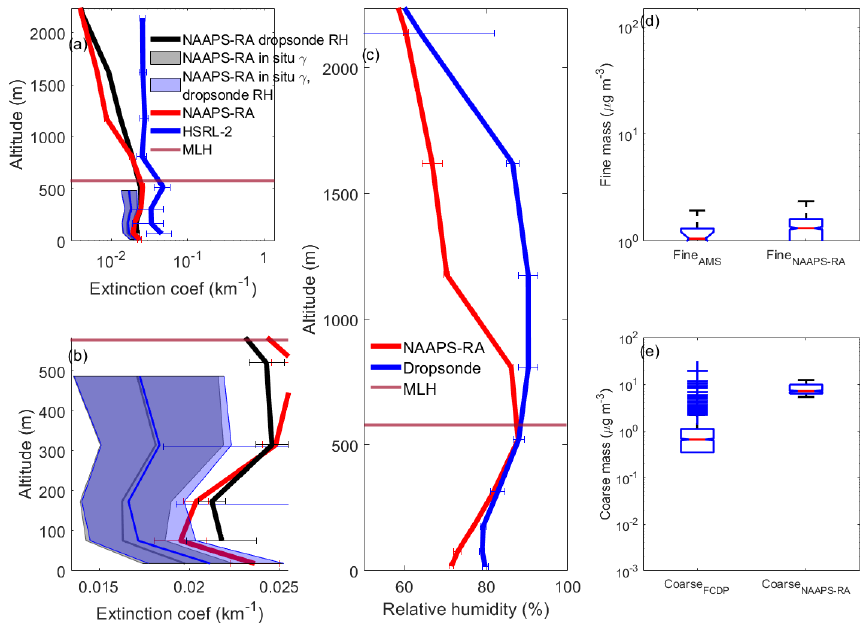
Figure 7. Comparison of model output and observations for Case I (RF19) on 5 October 2019. (a) HSRL-2 (blue) and NAAPS-RA extinction profiles when NAAPS-RA extinction coefficients were calculated using either NAAPS-RA RH (red) or dropsonde RH (black). Shaded profiles indicate NAAPS-RA extinction coefficients calculated using in situ γ values and either NAAPS-RA RH (grey shaded profile) or dropsonde RH (blue shaded profile). For each shaded profile, the middle line and lines bordering the right and left of each shaded profile indicate extinction coefficients calculated with either the mean γ , mean γ plus 1 standard deviation, or mean γ minus 1 standard deviation, respectively. (b) Shaded profiles shown in greater detail. (c) Dropsonde and NAAPS-RA RH profiles. Simulated and observed fine (d) and coarse (e) mass concentrations. The red line in the center of each box of (d) and (e) represents the median, the edges of each box indicate the 25 and 75th quartiles, blue crosses belong to outliers lying in the fourth quartile, and notches represent the 95% confidence interval. Horizontal magenta lines in (a) , (b) , and (c) indicate the mixed-layer height (MLH;